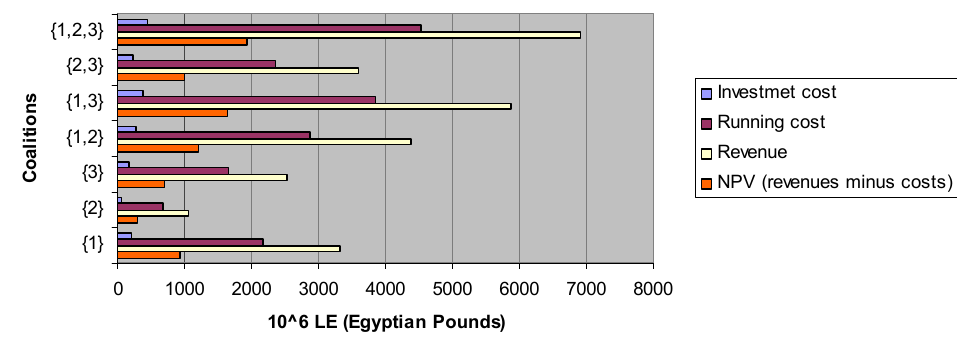
Figure 3. Present values of cost and revenues games under Alternative A0. Investment cost: Present values of coalitions in the investment cost game i A0 . Running cost: Present values of coalitions in the running cost game i A0 . Revenue: Present values of coalitions in the revenue game V A0 . NPV (revenues minus costs): Total net present value obtained as the difference between revenues and costs.